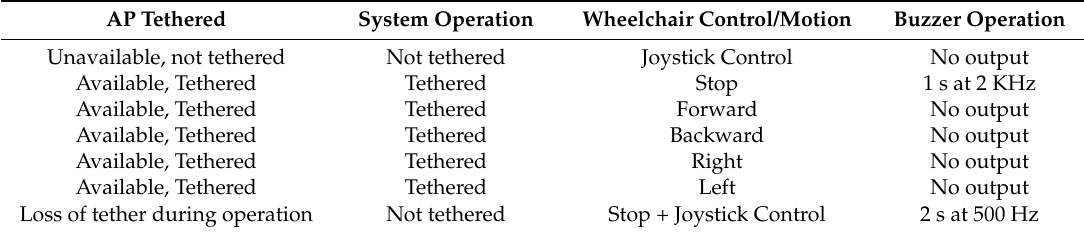
Table 2. Ultrasonic tethering system modes of